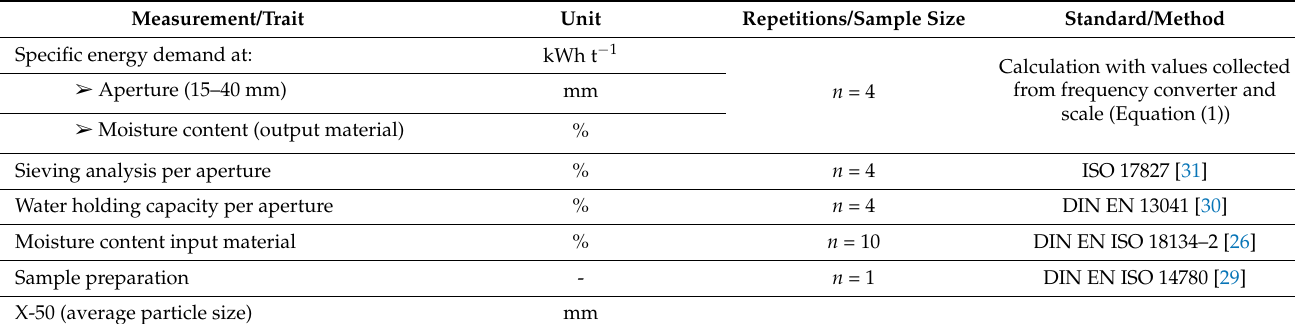
Table 1. Overview of all investigated traits, number of samples, and